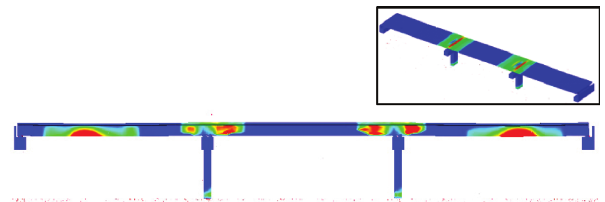
Figure 22: Principal normal strain during the time of “model A3-C-K.”